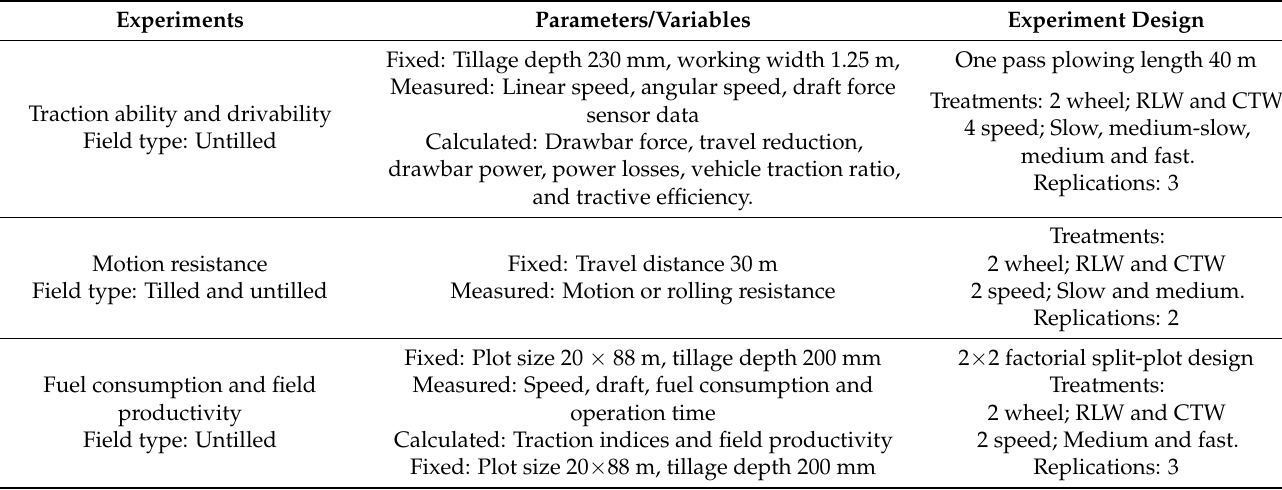
Table 2. Experimental plan for traction performance indices, energy efficiency, and field productivity.